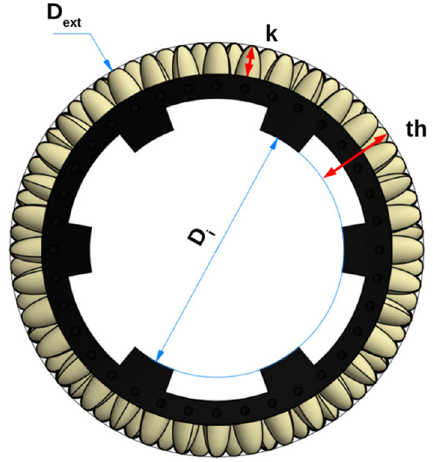
Figure 3. Definition of roughness parameters adapted to the experimental set-up.